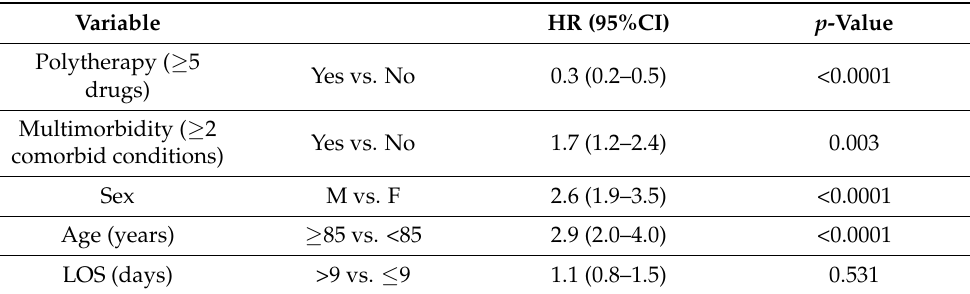
Table 4. Results from multivariable Cox model for 1-year mortality. HR = Hazard ratio; LOS = length of stay in